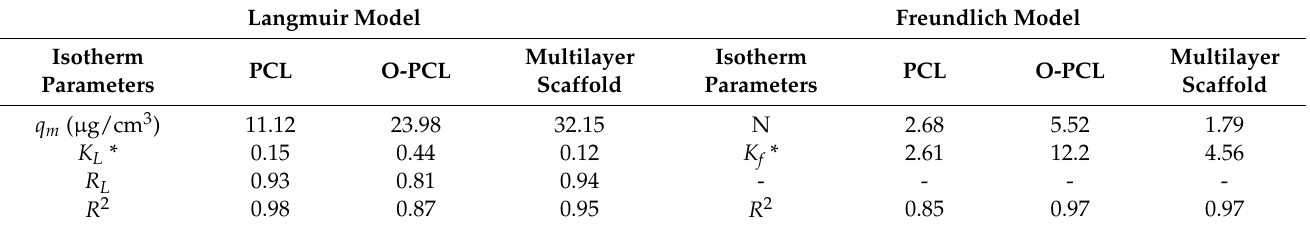
Table 4. Langmuir and Freundlich model parameters for fitting the FBS proteins adsorption isotherms. q m ( µ g/cm 3 ) is the monolayer capacity of the adsorbent, N is the constant exponent that describes the intensity of the adsorption process attributed to deviation from linearity, R 2 is the correla- tion coefficient of the goodness of fit, and K L (mL/mg) and K f are the Langmuir and Freundlich isotherm constants.